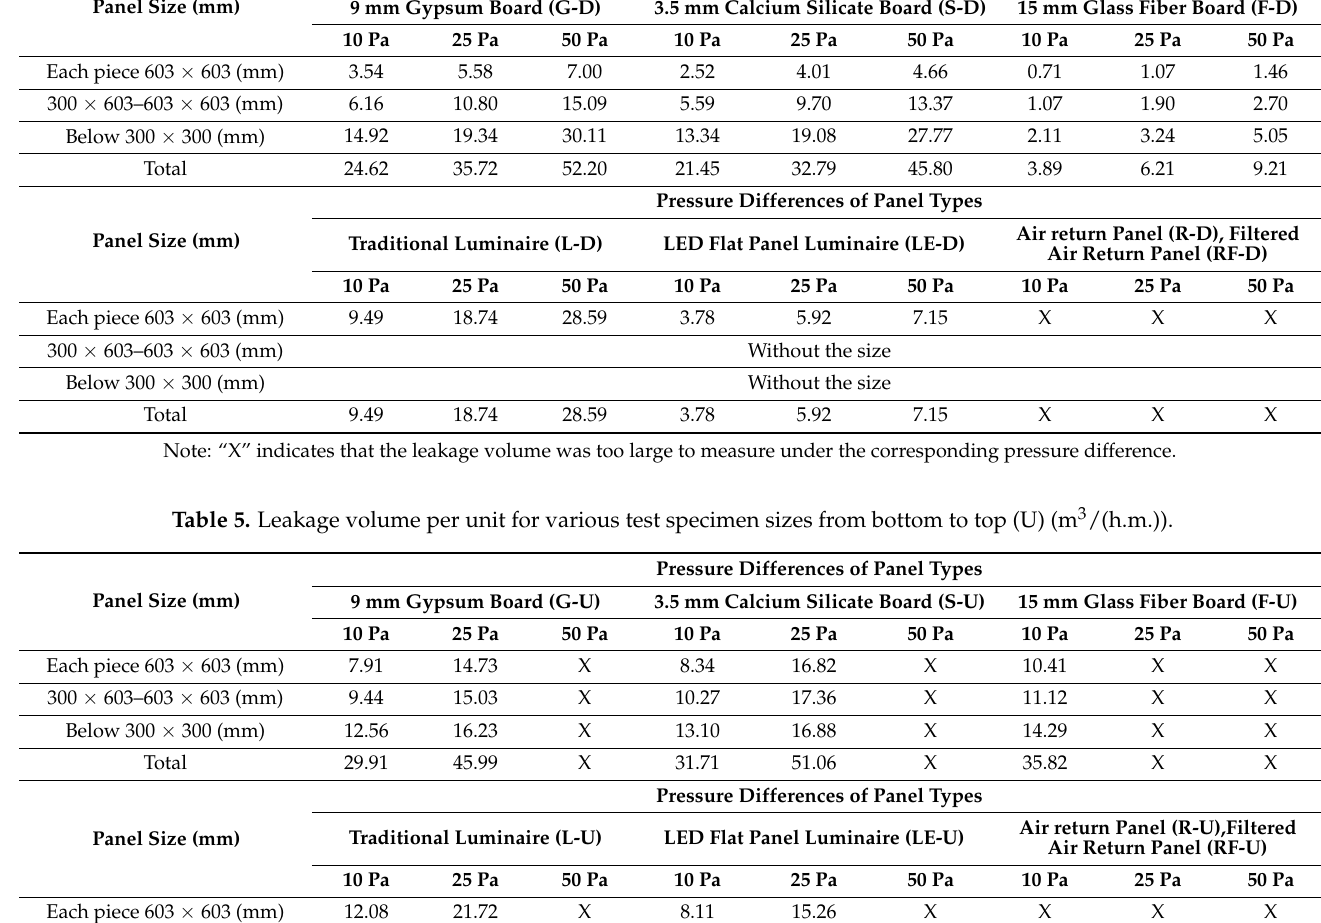
Table 4. Leakage volume per unit for various test specimen sizes from top to bottom (D) (m 3 /(h.m)).